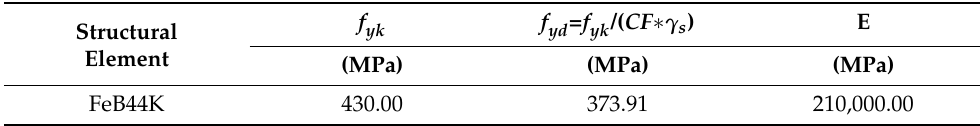
Table 2. Mechanical properties of mild steel